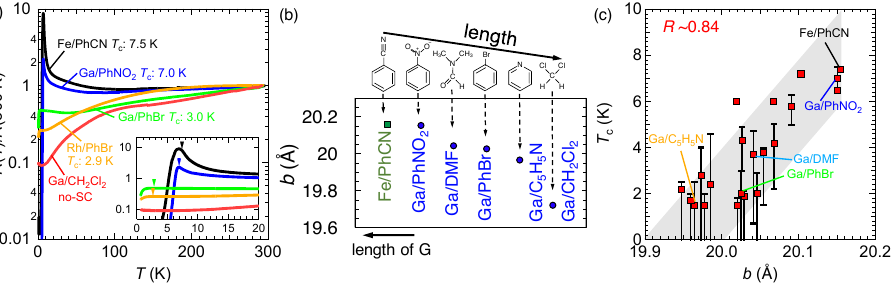
Figure 2. ( a ) Temperature dependence of the reduced electrical resistance R ( T )/ R (300 K) for some salts [41]. The inset is an expanded view below 20 K. The arrows indicate the superconducting transition temperatures T c determined by the onset of the drop of the resistance. ( b ) Schematic comparison of the b -axis length of some salts depending on the length of the guest molecule G . ( c ) T c vs. b of the reported M / G salts. The T c of each salt was determined from the resistivity data reported in Refs. [23,28,34–36,38,41–43]. This plot gives a large positive correlation coefficient R ∼ 0.84. The bars indicate the onset and zero-resistivity temperatures.